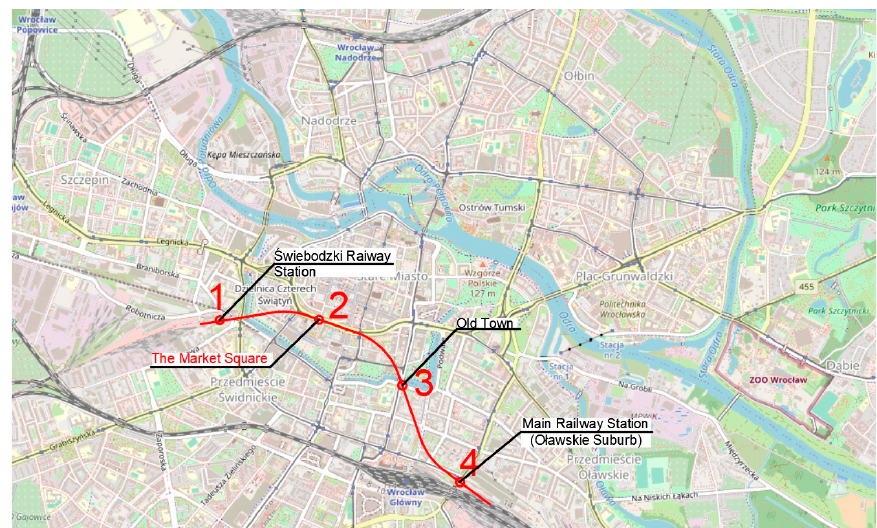
Figure 8. Route four (background: openstreetmap.org).